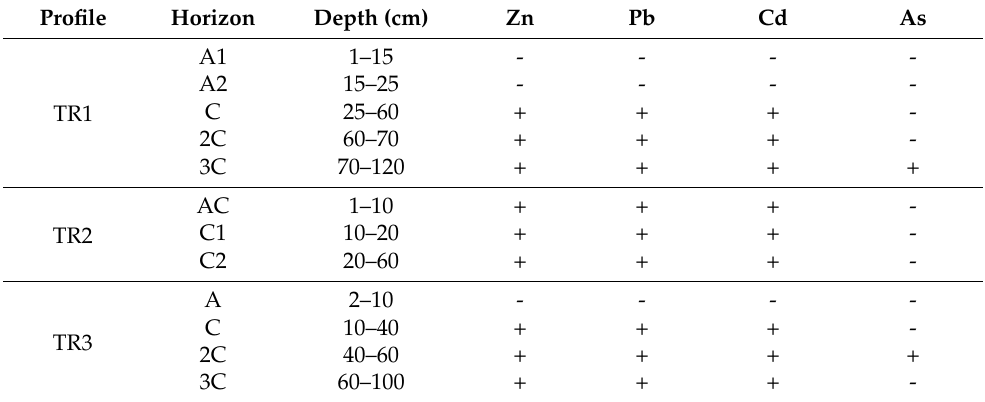
Table 6. Exceeded content of trace elements in soils (group IV) according to the Polish regulation [72].